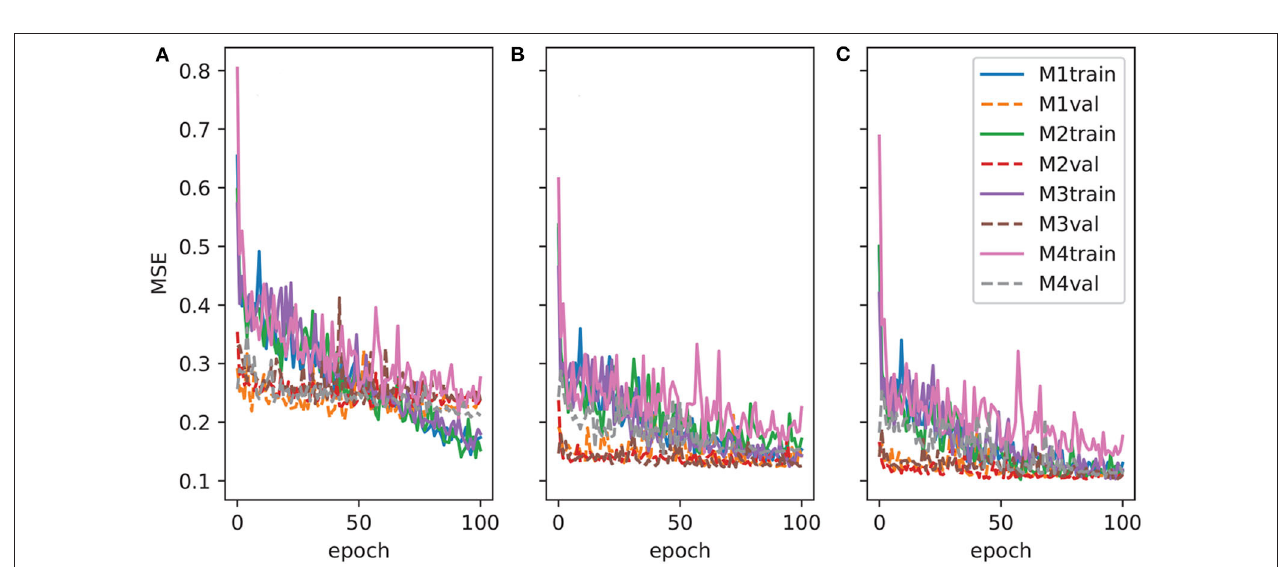
where y g and ˆ y are measured and predicted data at a gauge location, N G is the number of usable gauge data for a month, and µ and σ denote mean and standard deviation. If multiple gauges exist in a grid cell, we used the average of gauge values for that cell. Mean metric values were then obtained by averaging over all months in the testing